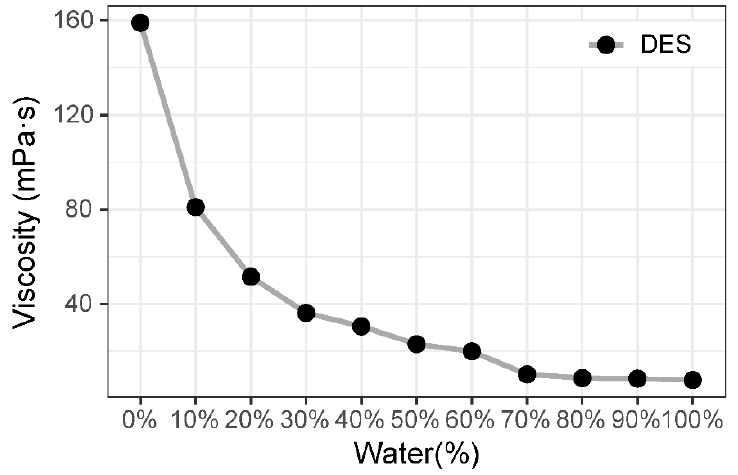
Figure 1. The viscosity of DES was related to the water content.